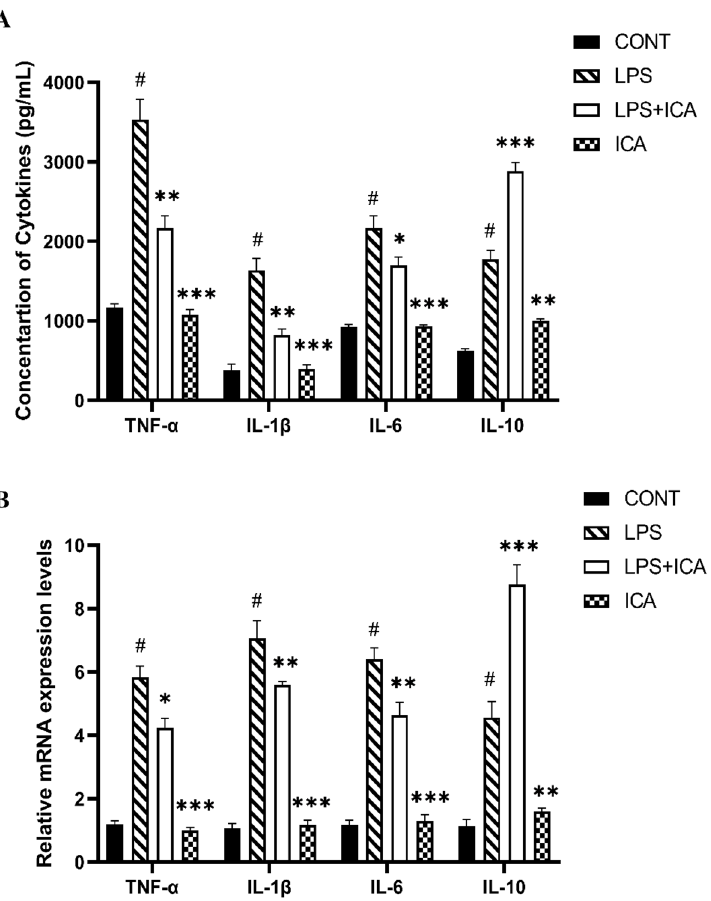
Figure 3. Effect of ICA in LPS-triggered secretion of cytokines. ( A ) Concentration of TNF- α (pg/mL), IL-1 β (pg/mL), IL-6 (pg/mL) and IL-10 (pg/mL). ( B ) The relative mRNA expression levels of TNF- α , IL-1 β , IL-6, and IL-10. The data were statistically presented as means ± SEM. The # p < 0.001 between CONT and LPS groups, and * p < 0.05, ** p < 0.01, *** p < 0.001 between LPS and ICA therapy groups. (CONT, LPS, and ICA stand for control, lipopolysaccharide, and Icariin groups. [The ICA dose used was 50 mg/kg for uterine